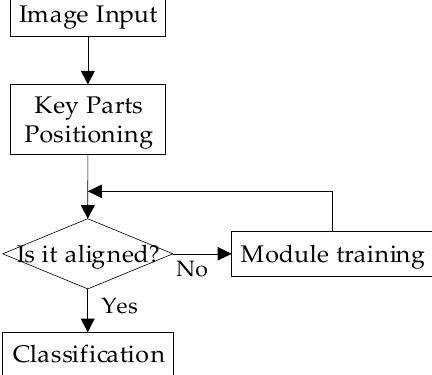
Figure 2. Process of methods based on detection and alignment. First, images are input into convolutional neural networks (CNNs), through which the key points or regions can be extracted and located. Thereafter, the module determines whether the images are aligned with prototypes. If not aligned, the images would be trained again until they are aligned. Finally, the images can be classified accurately.